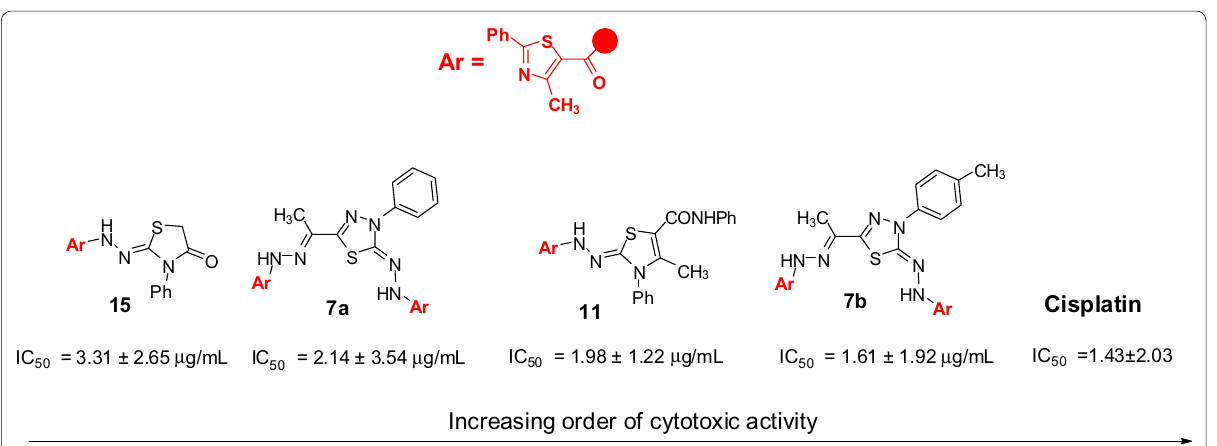
Fig. 4 The ascending order of the cytotoxic